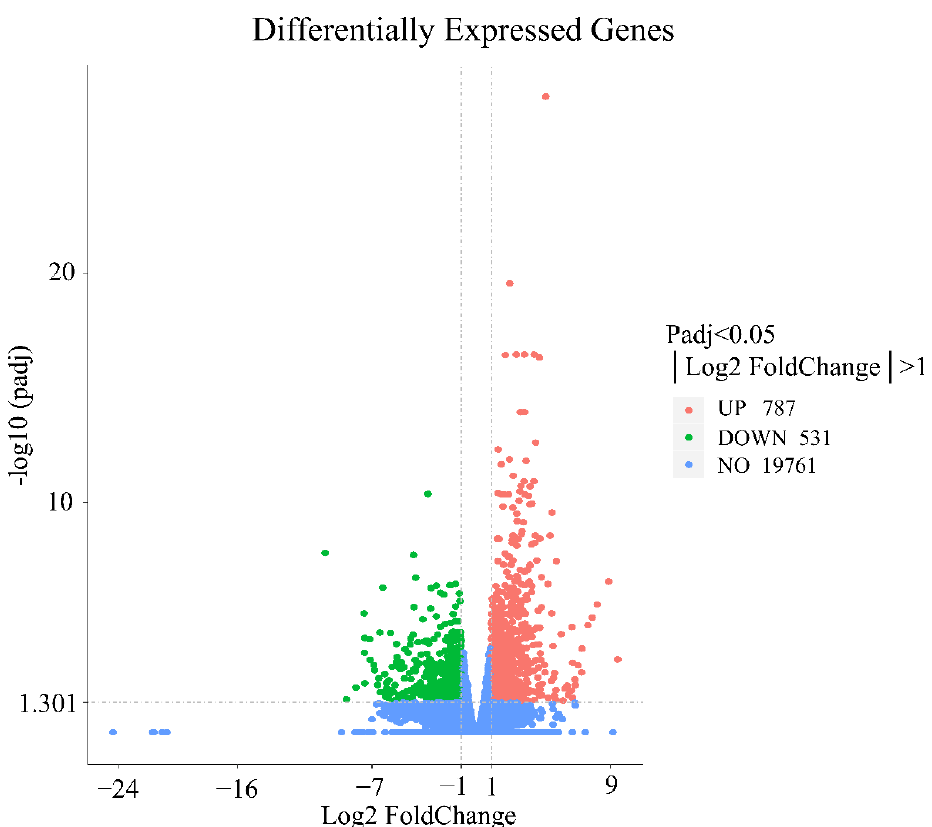
Figure 2. Differential mRNA expressions between the treatment and control groups. Red dots indicate significantly upregulated genes, green dots indicate significantly downregulated genes, and blue dots indicate genes with no difference.